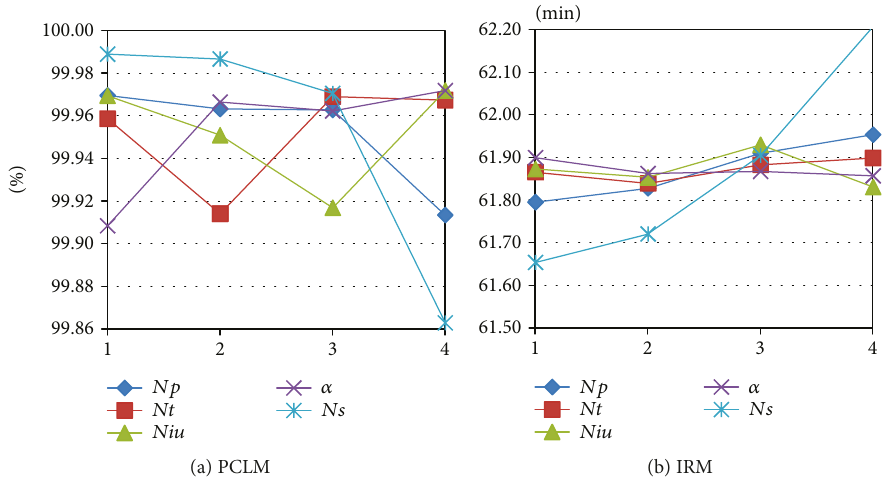
Figure 10: In fl uence of the parameters on the robust objectives under distribution level I.